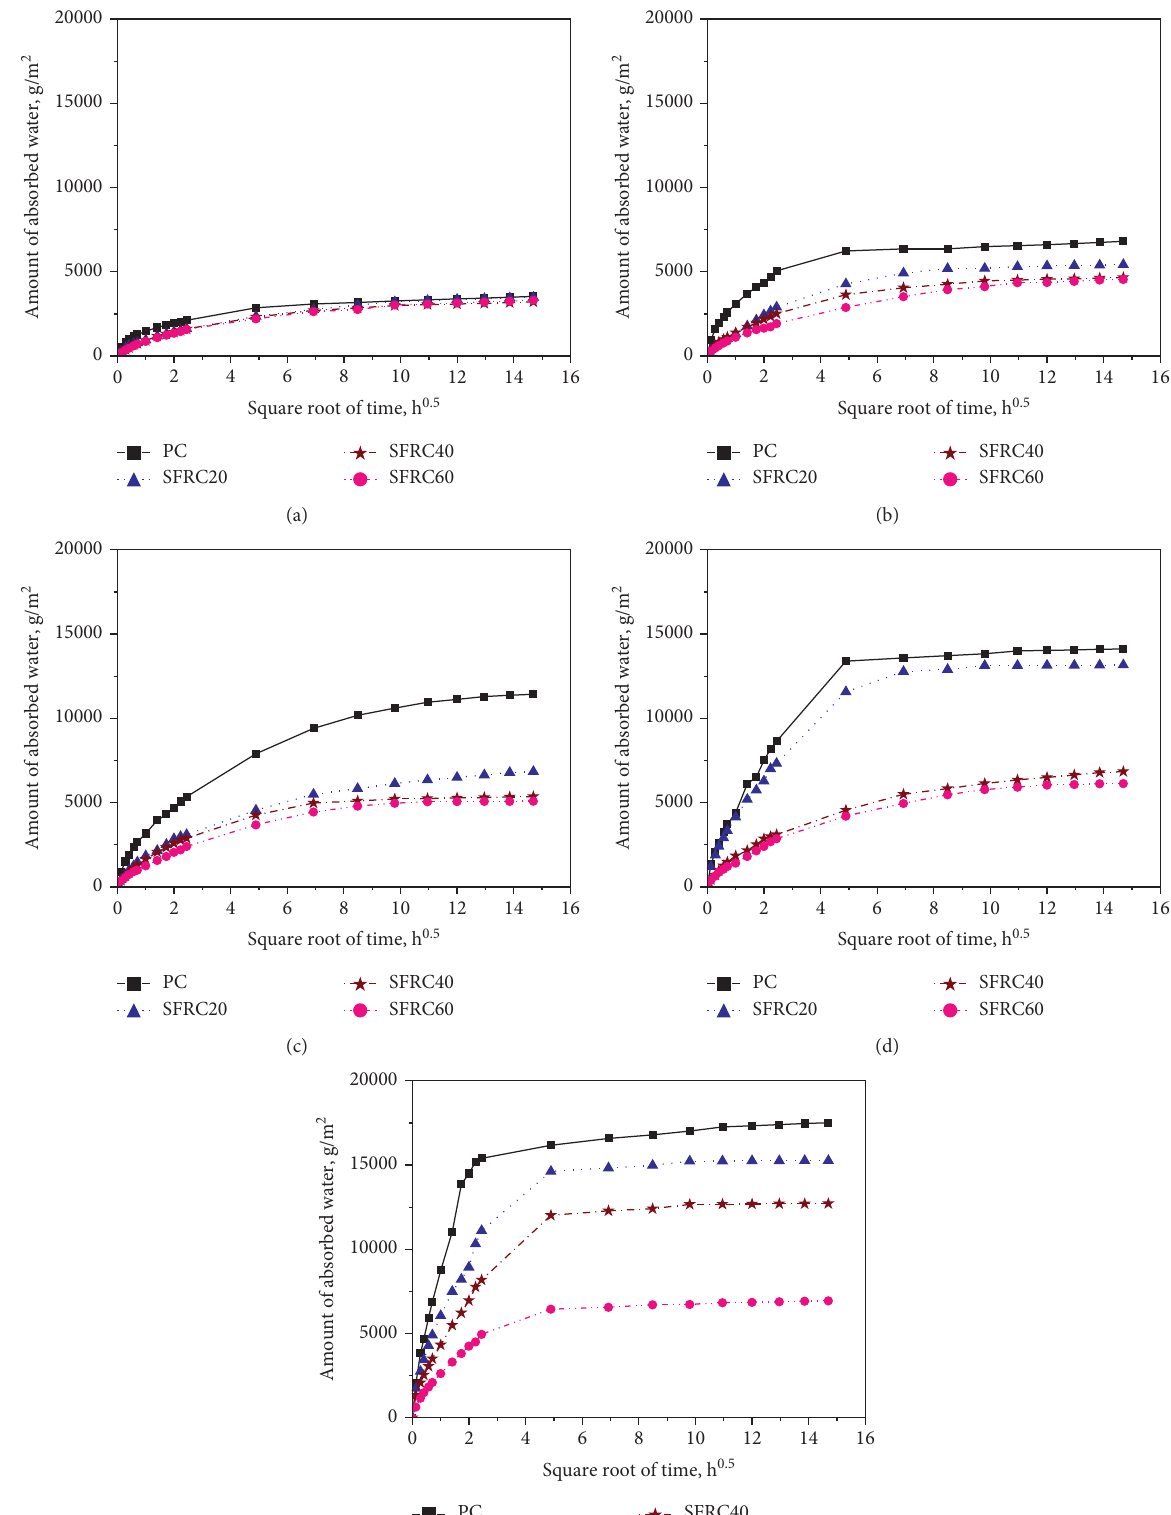
Figure 6: Comparison of the CWA of the samples after different FTCs: (a) 0; (b) 25; (c) 50; (d) 75; (e)